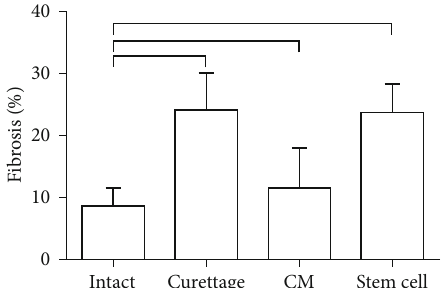
Figure 5: Mean and standard error of the amount of collagen fi bers in the endometrial layer to compare the preventive e ff ects of intrauterine bone marrow-derived mesenchymal stromal cell- (BM-MSCs-) conditioned media (CM) injection on uterine fi brosis after endometrial curettage in rabbit. The horizontal line above the columns show a statistically signi fi cant di ff erence ( P < 0 : 05